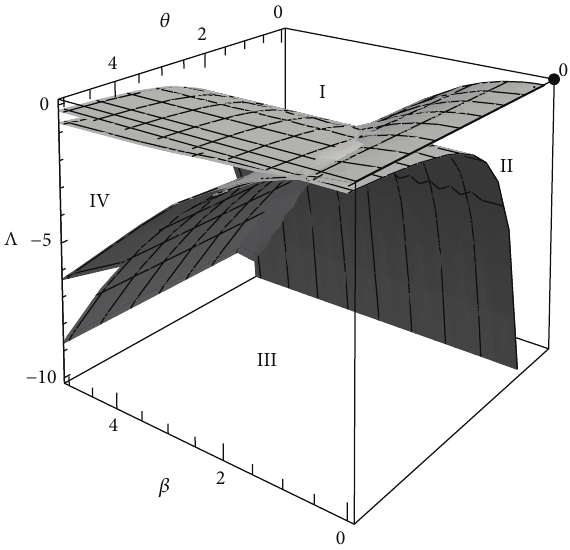
Figure 4: The parameter space where the Λ sponds to the regions I and III of the plot. In this plot the origin 0 is in the upper right